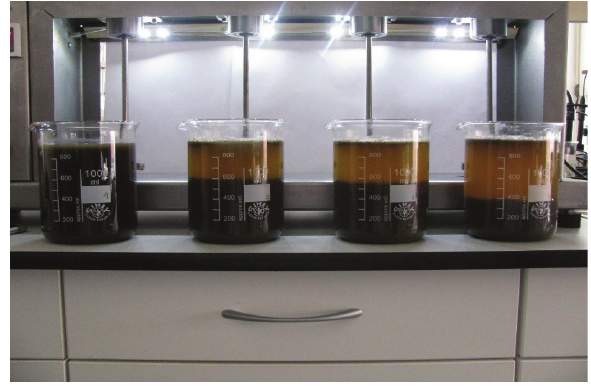
Figure 2: Jar test using different volumes of PACl.